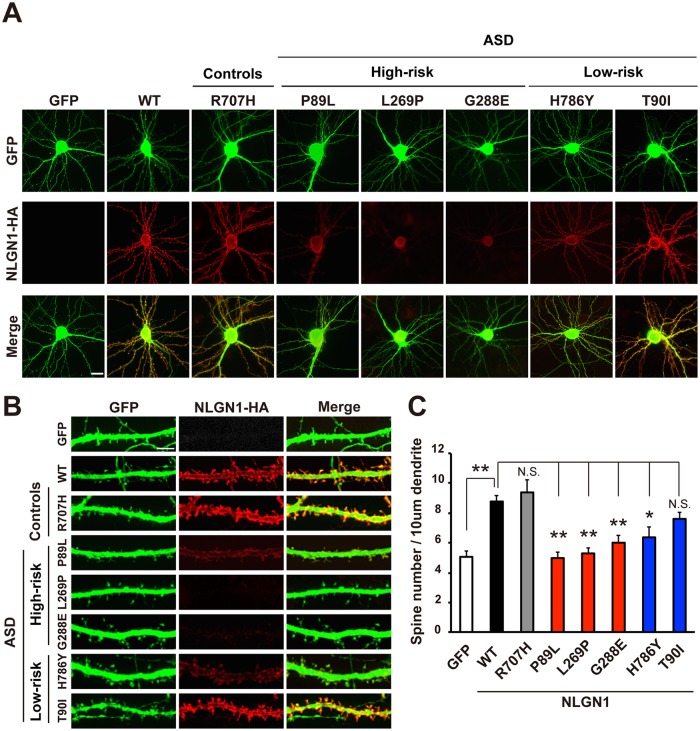
Impaired spine induction by NLGN1 variants observed in patients with ASD.(A) Representative fluorescence images of hippocampal neurons (DIV14) co-transfected with negative control, WT, and non-pathogenic NLGN1 or pathogenic NLGN1 variants with GFP expression vector. NLGN1 expression of pathogenic variants (P89L, L269P, G288E, and H786Y) was decreased compared to others. (B) Representative images of spines from neurons transfected with negative control, WT, and non-pathogenic NLGN1 or pathogenic variants of NLGN1. (C) Quantification of the number of spines. Spine number in dendrite was significantly lower in four pathogenic variants (P89L, L269P, G288E, and H786Y) compared to WT, and no significant differences between GFP-transfected control and these four variants were observed. Data represent mean ± S.E.M. (*p<0.05, **p<0.01 Tukey-Kramer’s multiple comparisons test). More than 14 neurons are counted for each NLGN1 variant. Scale bar indicates 20 μm for (A) and 5 μm for (B).